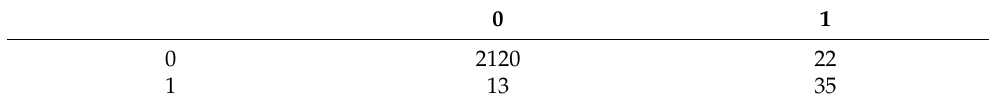
Table 8. Confusion matrix corresponding to the FD-LOCI application, assuming θ = 0.78 and a sampling radius that accounts for 50% of the observations (neighbors), n 0 = 1095